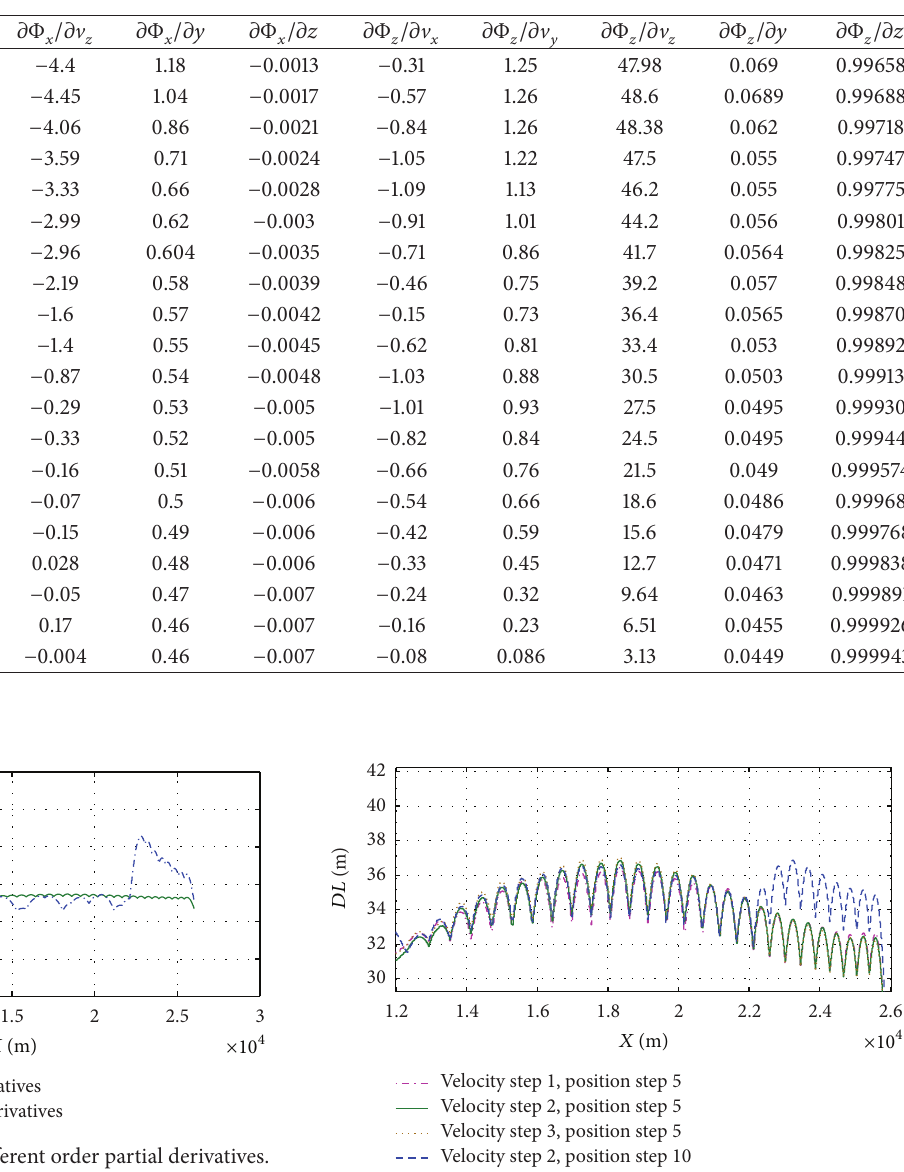
Figure 8: Predictive results with different velocity and position